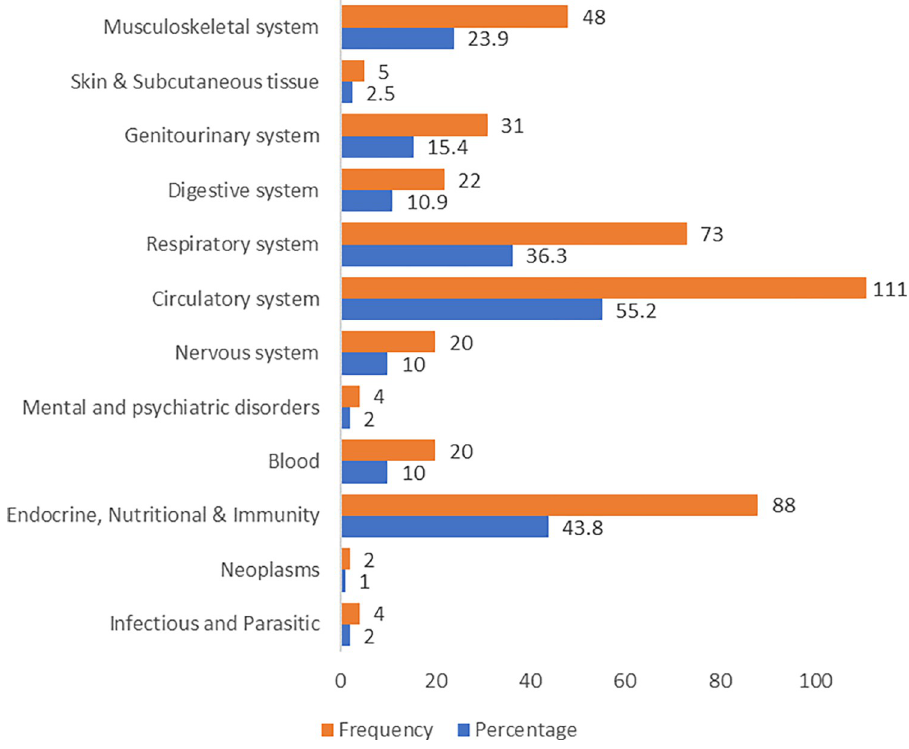
Fig 1. Frequency and percentages of chronic diseases among the study population (N =